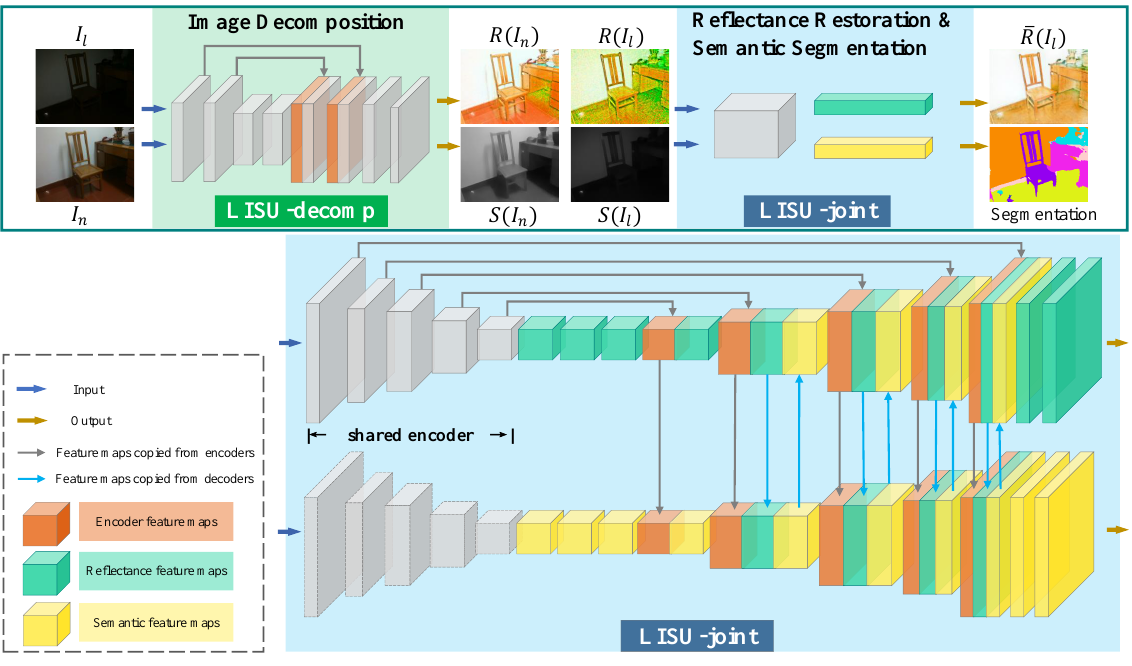
Figure 2. The cascade architecture of our LISU network, which consists of LISU-decomp and LISU-joint. LISU-decomp learns the decomposition of each input image, and LISU-joint jointly learns the reflectance restoration and semantic